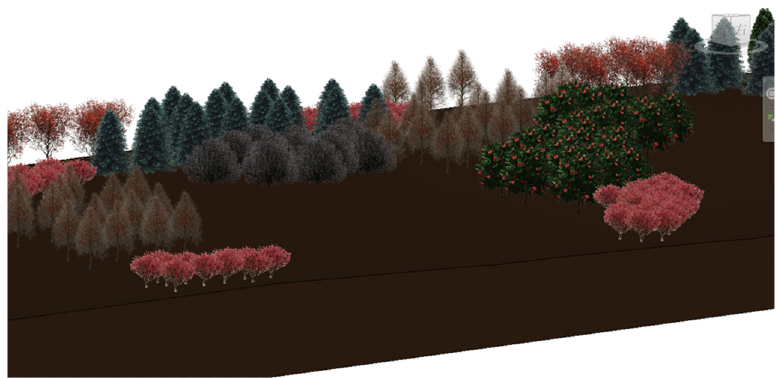
Figure 9. Batch generation of plant information models.